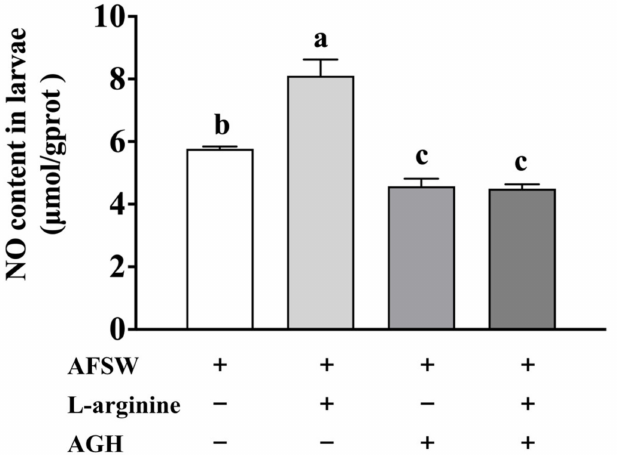
Figure 1. NO level in larvae after L-arginine and AGH exposure for 72 h. Values represent mean ± SEM ( n = 120), and bars with different letters indicate significant differences ( p <